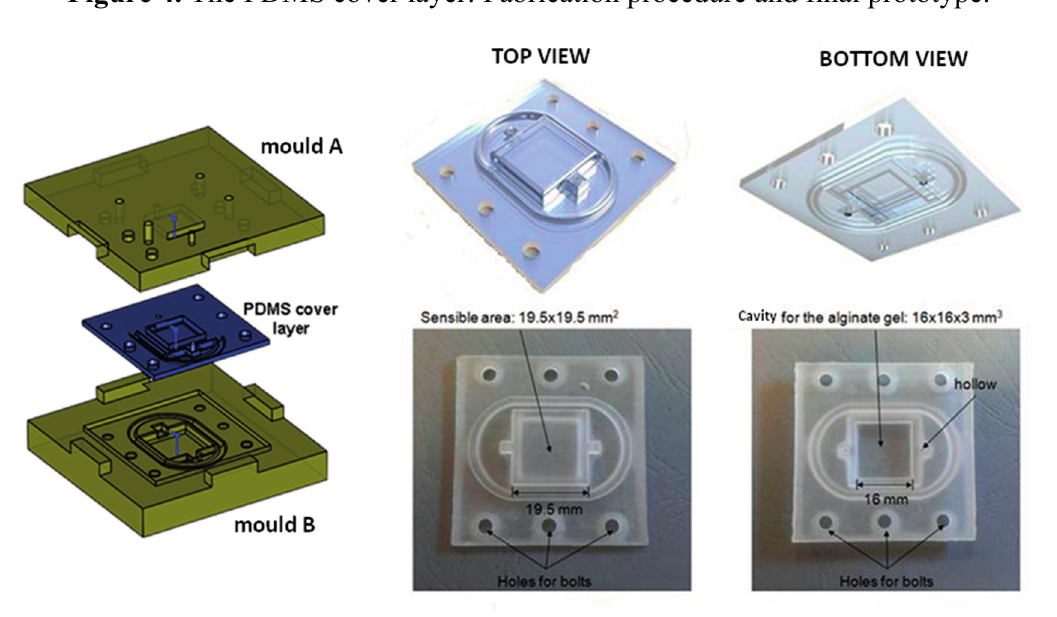
Figure 4. The PDMS cover layer: Fabrication procedure and final